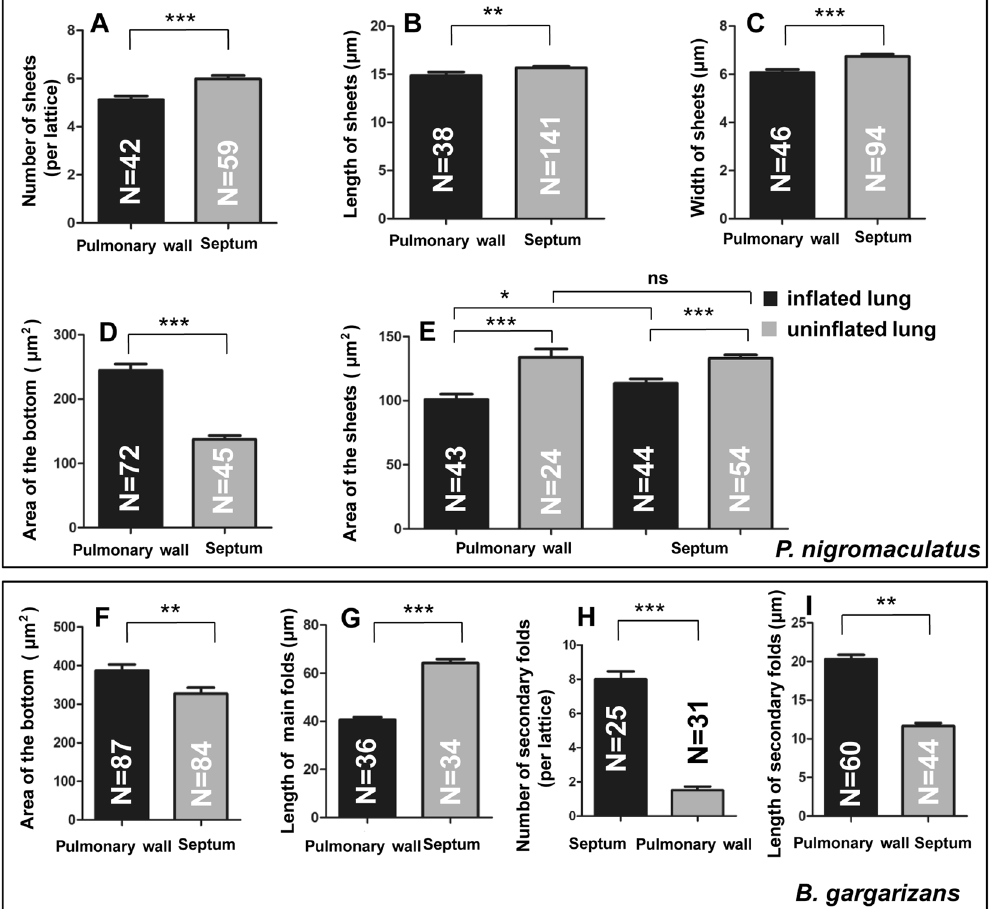
Figure 3. Comparative analysis of the pulmonary wall and septum in P. nigromaculatus and B. gargarizans . Number ( A ), length ( B ), and width ( C ) of the sheets in the pulmonary wall and septa in the inflated lung. Area of the lattice bottom in the pulmonary wall and septa in inflated lungs ( D ). Area of the sheets in the pulmonary wall and septa in both inflated and uninflated lungs ( E ). Area of the lattice bottom ( F ), length of the thick folds ( G ), and number ( H ) and length ( I ) of the thin folds in inflated lungs. The error bars indicate the SEMs, t test, two-tailed, * p < 0.05, ** p < 0.01, *** p <